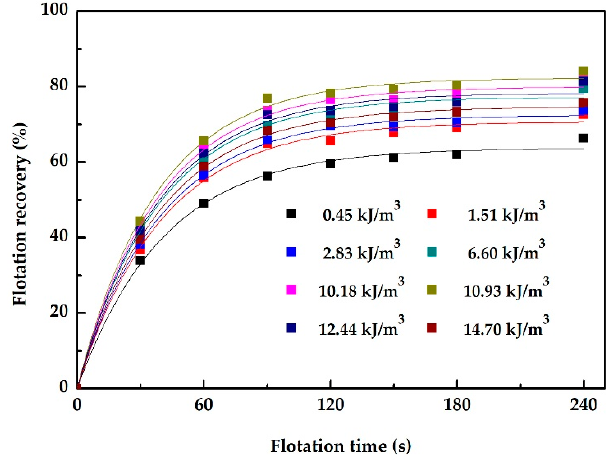
Figure 7. Flotation performance under different energy input conditions. Table 3. Fitting results of the flotation performance with different energy input conditions.